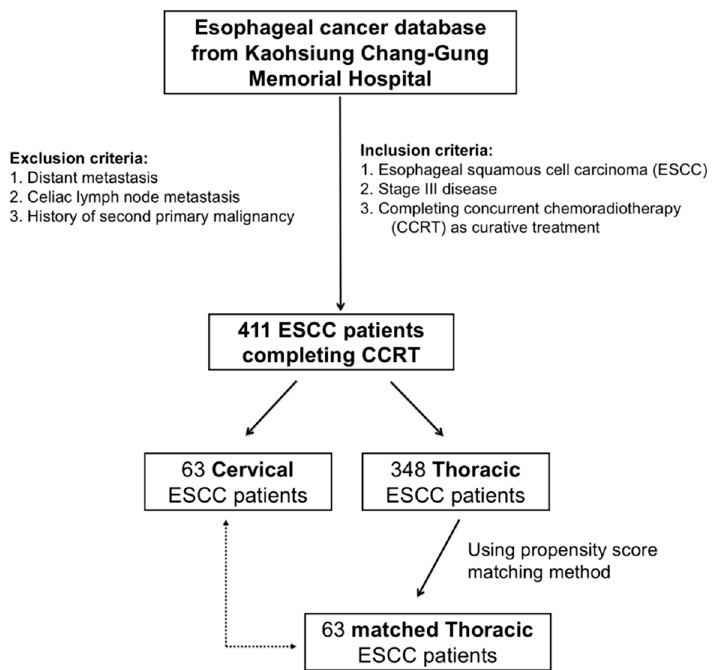
Figure 5. Algorithm for selecting patients with cervical and thoracic esophageal squamous cell carcinoma (ESCC).